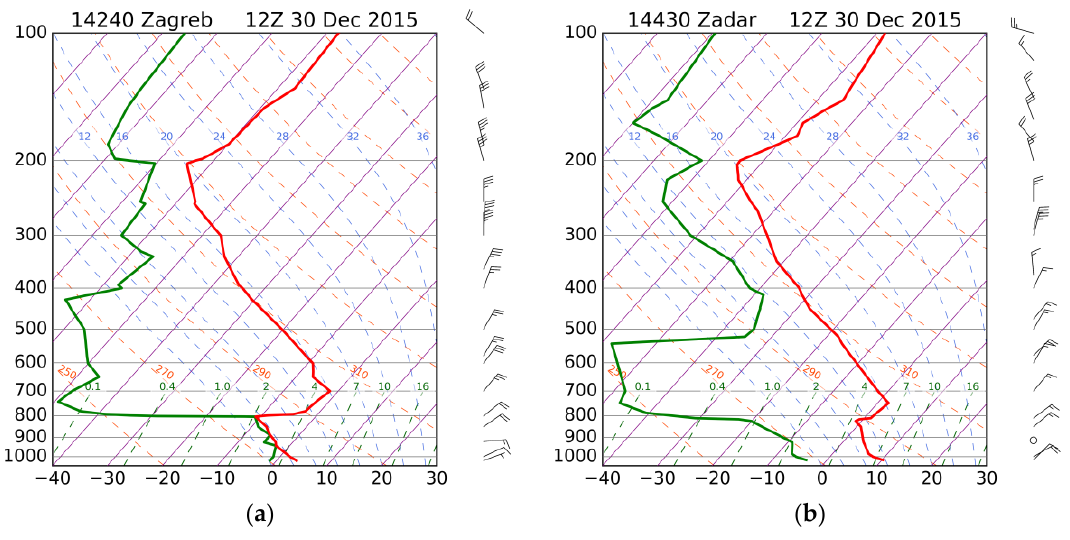
Figure 7. As with Figure 4, but for the bora episode B09 (DA); 12 UTC on 30 December 2015.